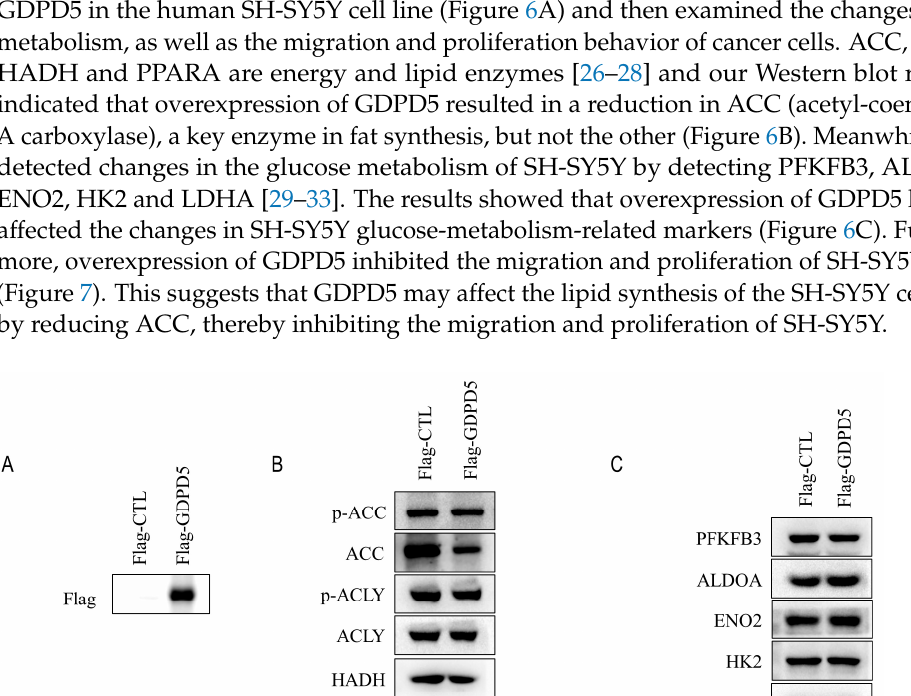
Figure 6. Immunoblot analysis. ( A ) Immunoblot analysis of transfected flag-GDPD5 or transfected flag-ctrl. ( B ) Western blot analysis of lipid-metabolism-related markers. ( C ) Western blot analysis of markers related to glucose metabolism. ACC (Acetyl-CoA Carboxylase Alpha), ACLY (ATP Citrate Lyase), HADH (Hydroxyacyl-CoA Dehydrogenase), Fructose-2,6-Biphosphatase 3 (PFKFB3), PPARA (Peroxisome Proliferator Activated Receptor Alpha), ALDOA (Aldolase, Fructose-Bisphosphate A), ENO2 (Enolase 2), HK2 (Hexokinase 2), LDHA (Lactate Dehydrogenase A).